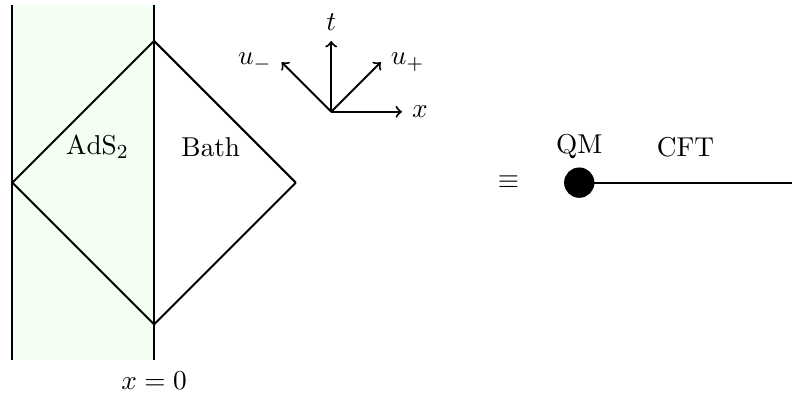
Figure 1 . Left: the Penrose diagram of the system. Dynamical gravity only lives in the green re- gion. Right: the quantum mechanical description of the system, which involves a (0+1) dimensional system coupled to a CFT on a half in(cid:12)nite